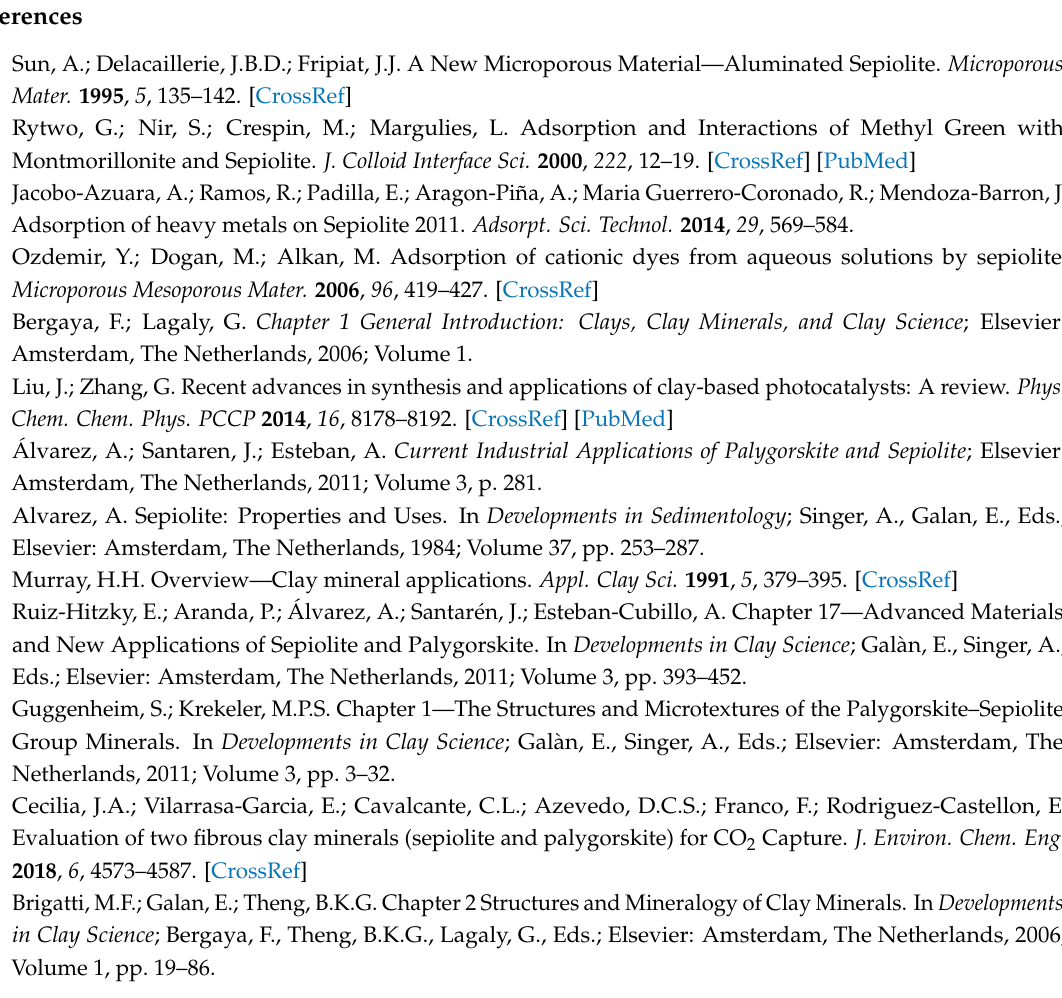
Figure S1: Chemical structures of dyes: (a) methylene blue (MB); (b) Rhodamine B (RhB); (c) Orange II (OII); (d) trypan Blue